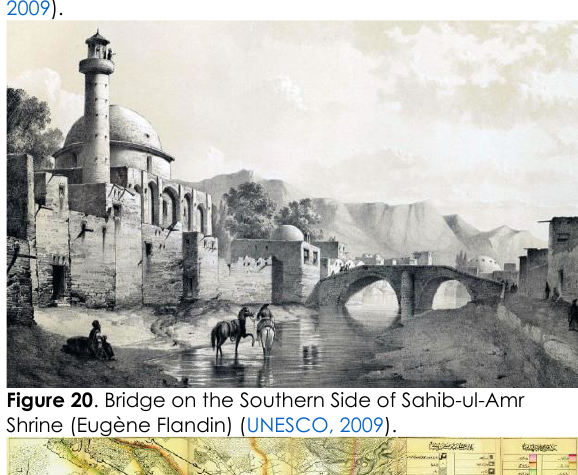
Figure 19 . Sketch of Sahebabad Square of Tabriz (UNESCO, 2009).